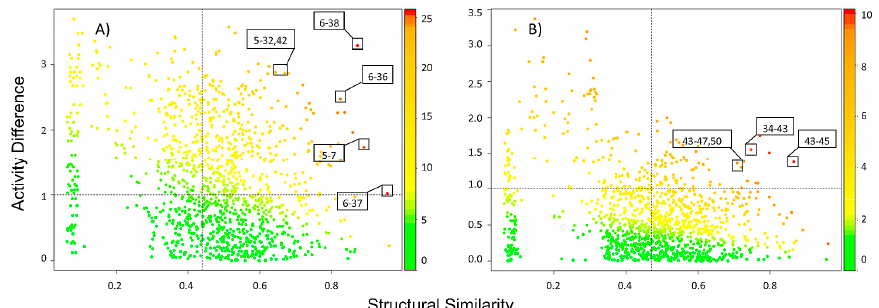
Figure 3. SAS map of compounds with activity against G9a ( A ) and DNMT1 ( B ). Data points are colored by SALI value using a continuous scale from low (green) to high (red).